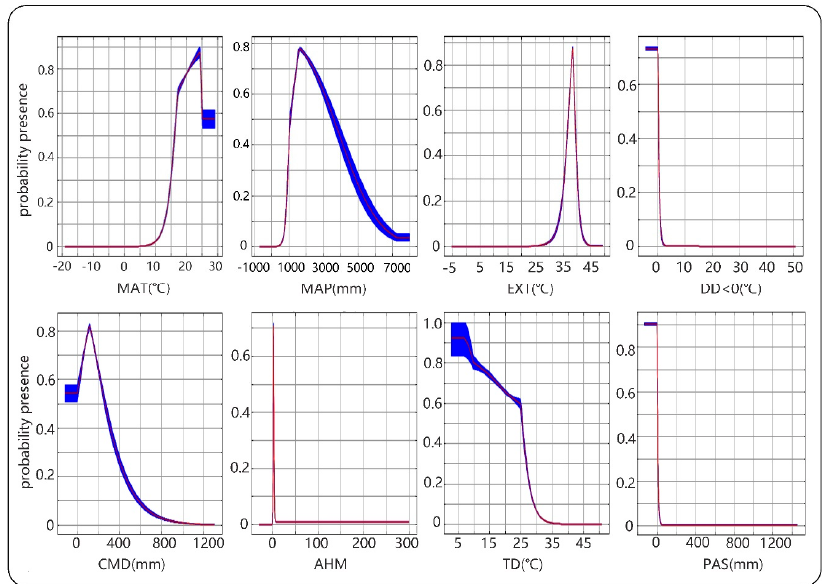
Figure 3. The response curves of eight environmental variables in camphor habitats distribution model. The logistic probability of presence is represented by the vertical axis and the climate variable by the horizontal axis. The values of probability presence range from 0 to 1, with values > 0.5 meaning a better than random fit. The red curves shown are the averages over 10 replicate runs; blue margins show ±1 standard deviation (SD) calculated over 10 replicates.